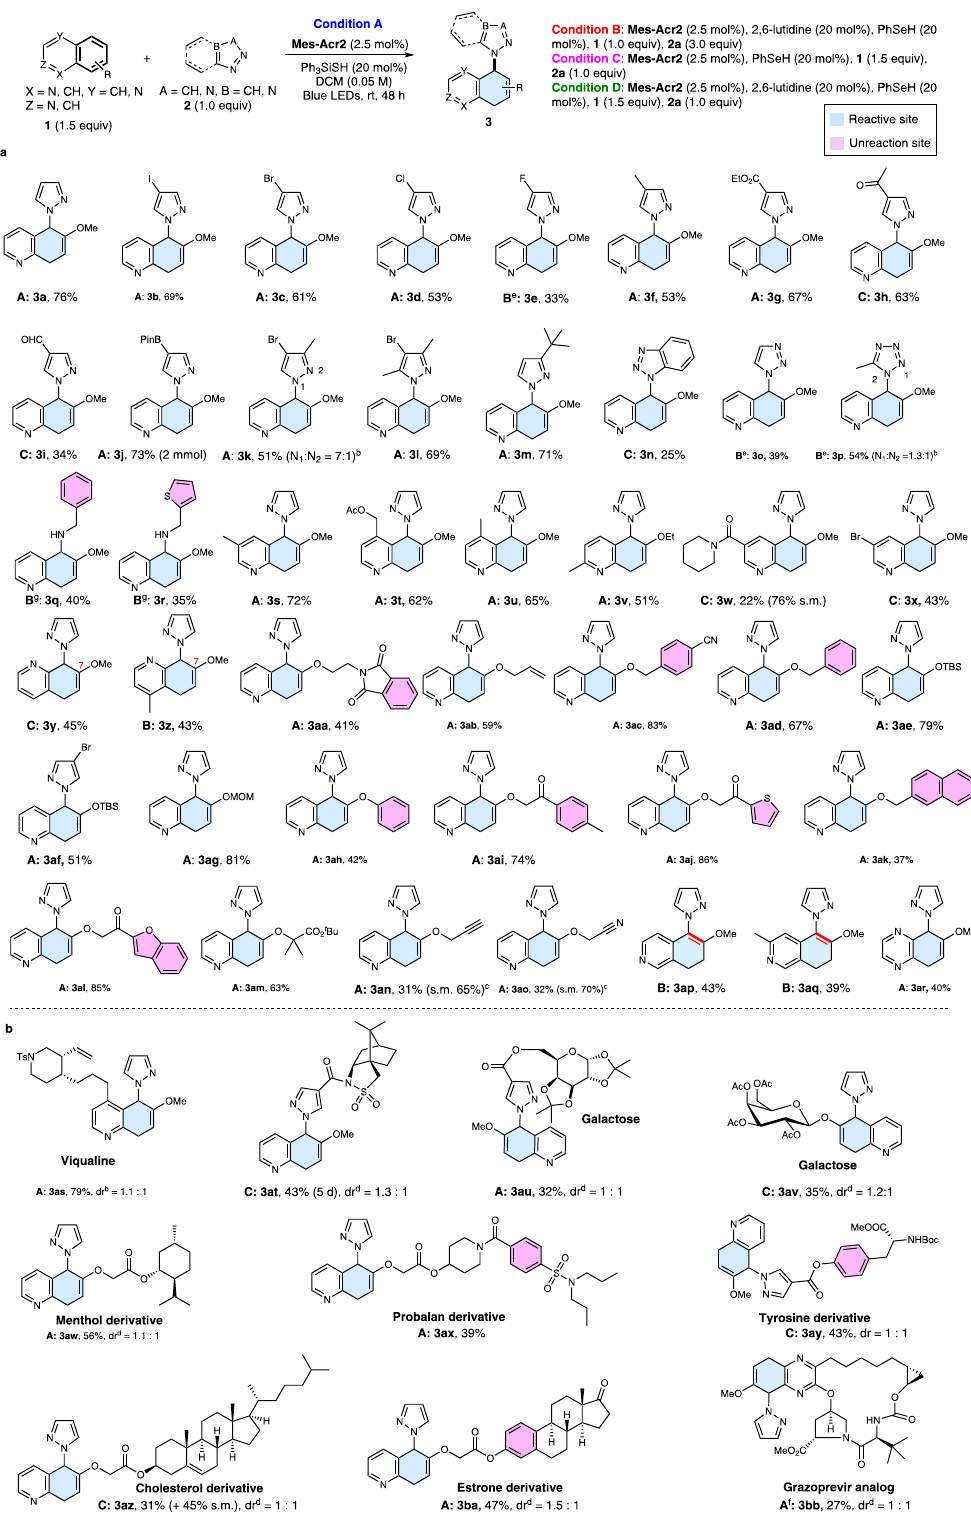
Fig. 2 | Scope of photoredox dearomative functionalization of quinolines, isoquinolines, and quinoxalines with azoles. a Scope of quinolines and quinox- alines with azoles. b Late-stage functionalization. a Reaction conditions: unless otherwise speci fi ed, see footnote a of Table 1 and supplementary information; b Ratio of isomers was determined by using 1 H NMR analysis of the crude reaction